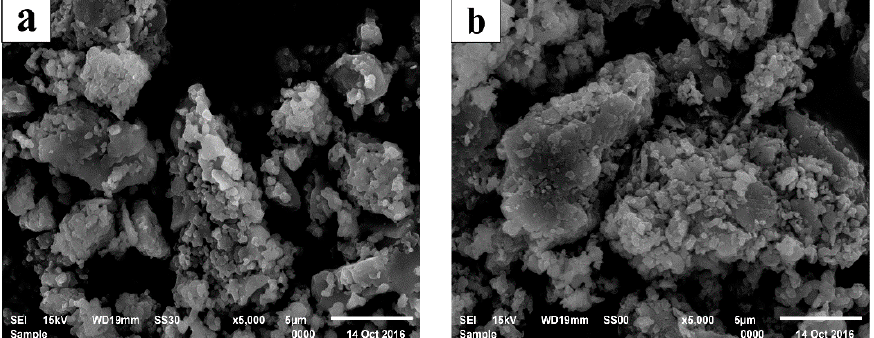
Figure 8. SEM images of the roasted samples at 850 °C: ( a ) Blank roasting; ( b ) Roasting with 3 wt % MgO.